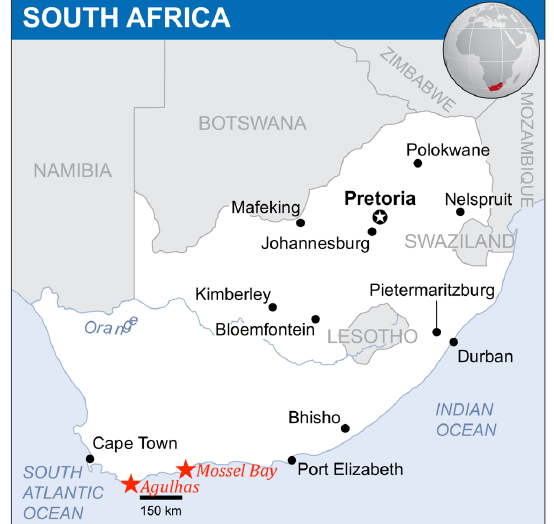
Figure 3. Locations of Agulhas and Mossel Bay in South Africa. Source for map of South Africa: UN Office for the Coordination of Humanitarian Affairs